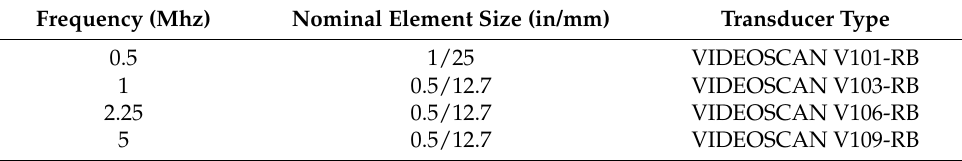
Table 1. Probe detail parameter.